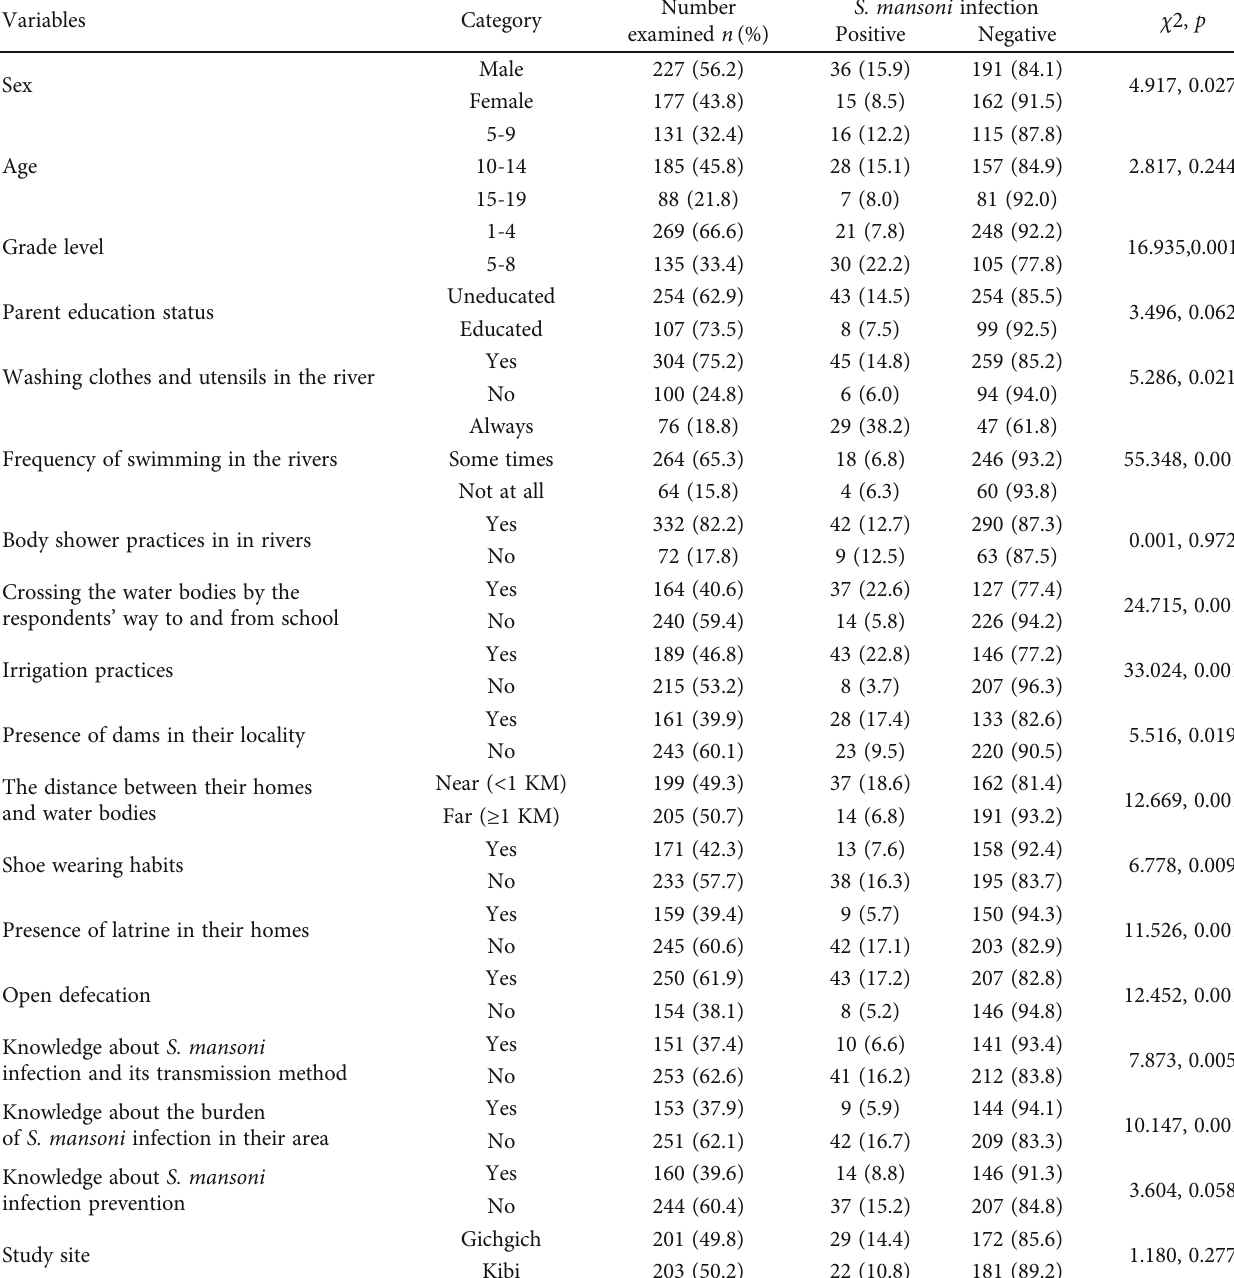
Table 2: Chi-square analysis of association of Schistosoma mansoni infection with socio demographic and associated risk factors of study participants in Gichgich and Kibi, Guangua district, northwest Ethiopia